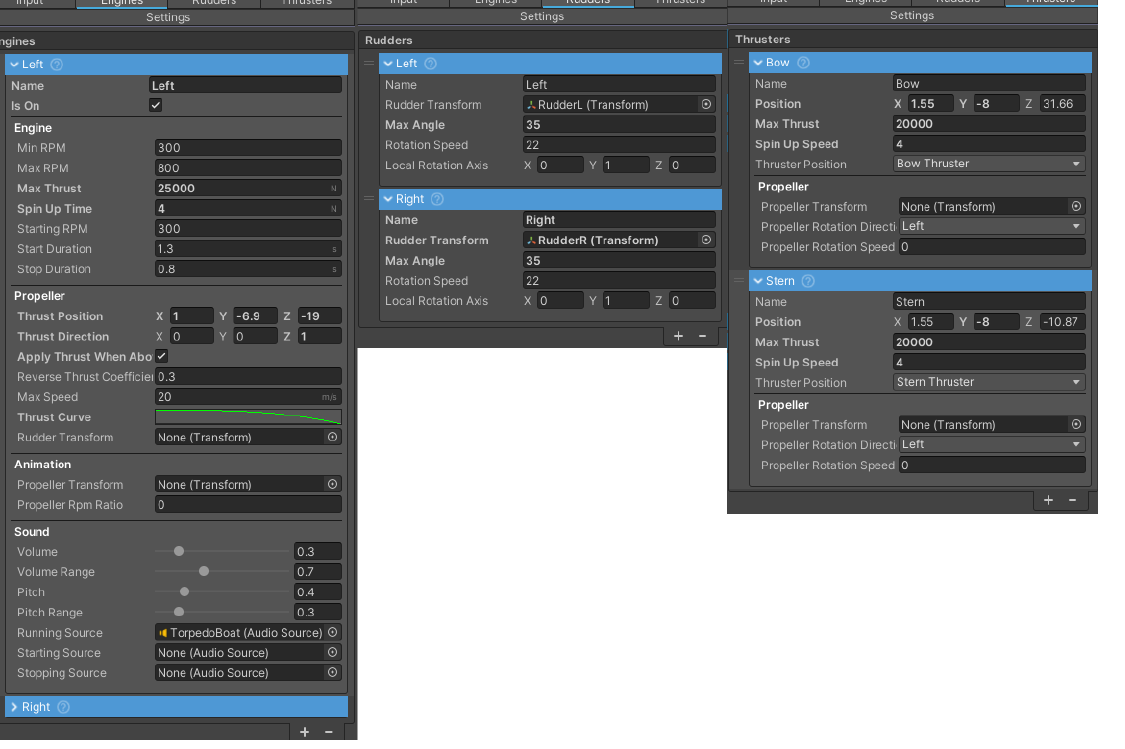
Figure 19. “ Rigidbody ” component. The “ Rigidbody ” component included following properties: •